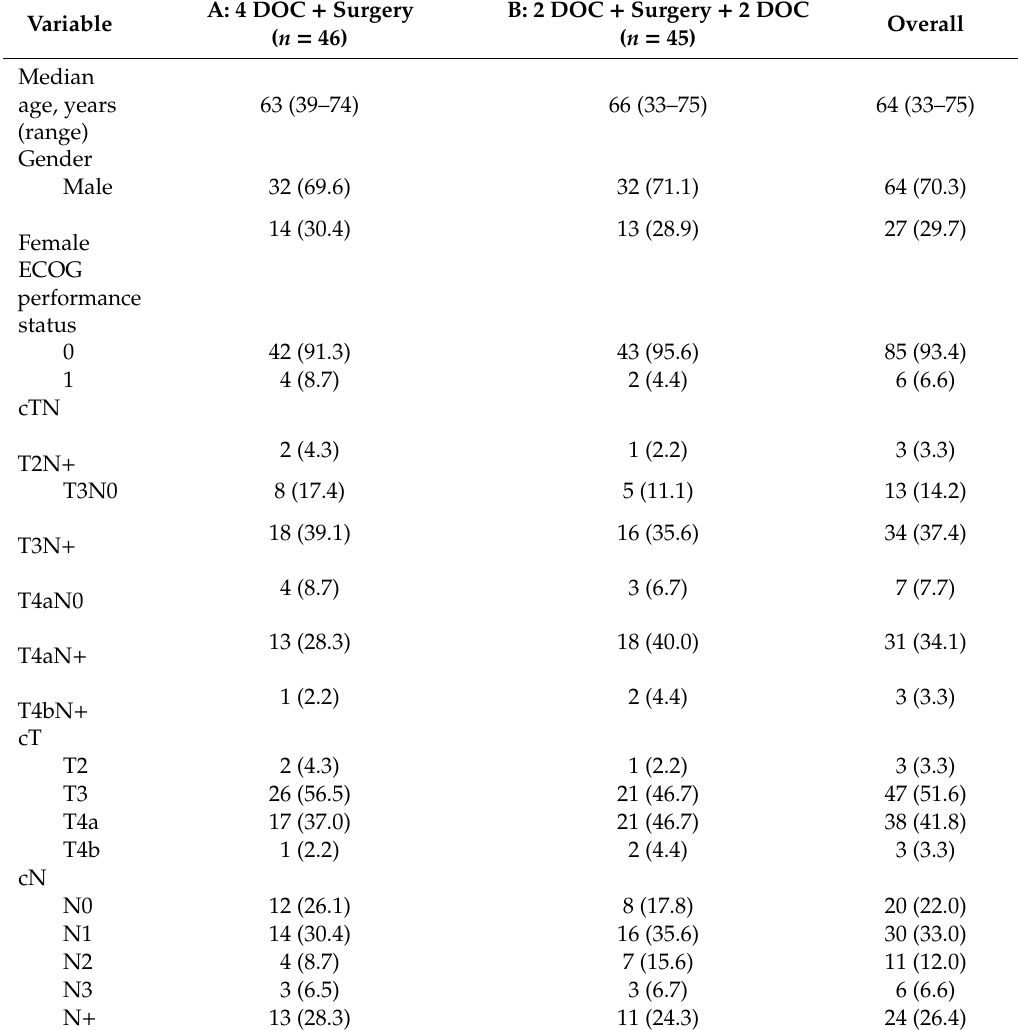
Table 1. Baseline patient characteristics.